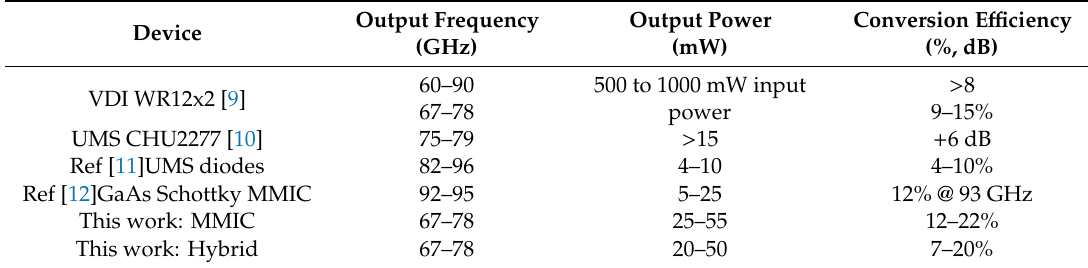
Table 1. Results for frequency doublers with output frequencies between 60 GHz and 96 GHz.